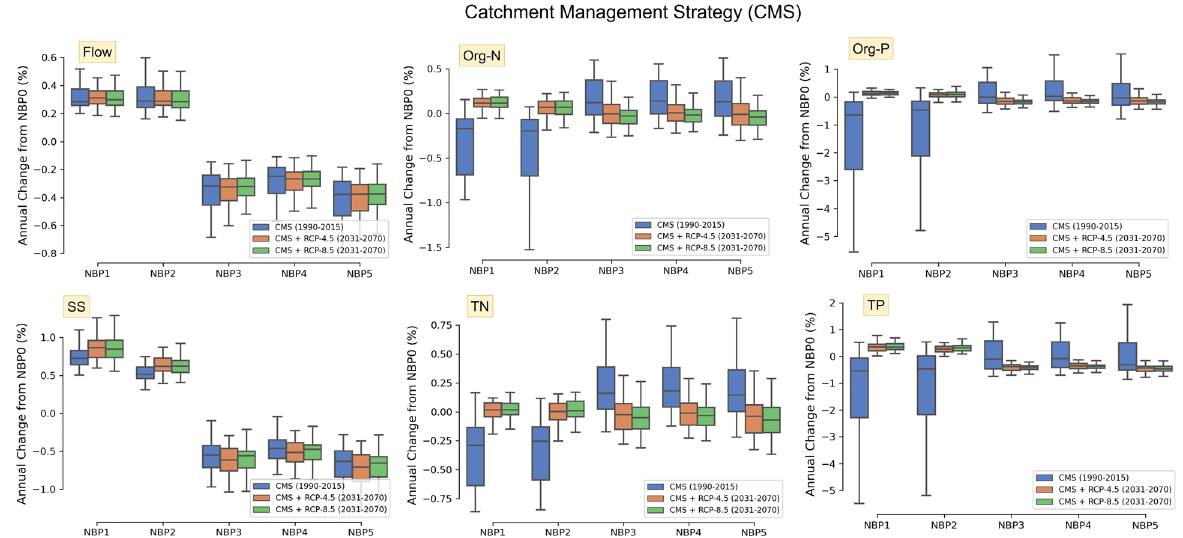
Figure 3. Changes in annual flow, nutrients, and SS for the CMS attribute of each NBP compared to NBP